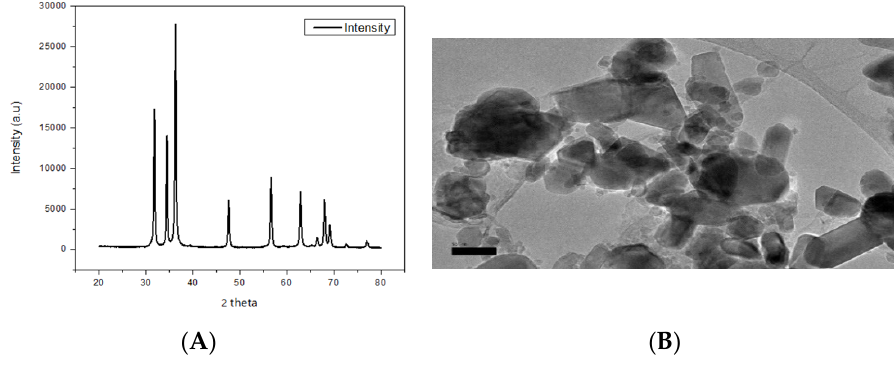
Figure 1. X-ray diffraction image ( A ) and transmission electron microscopy images (scale bar 50 nm) of ZnO NPs dispersed in ultra-pure water ( B